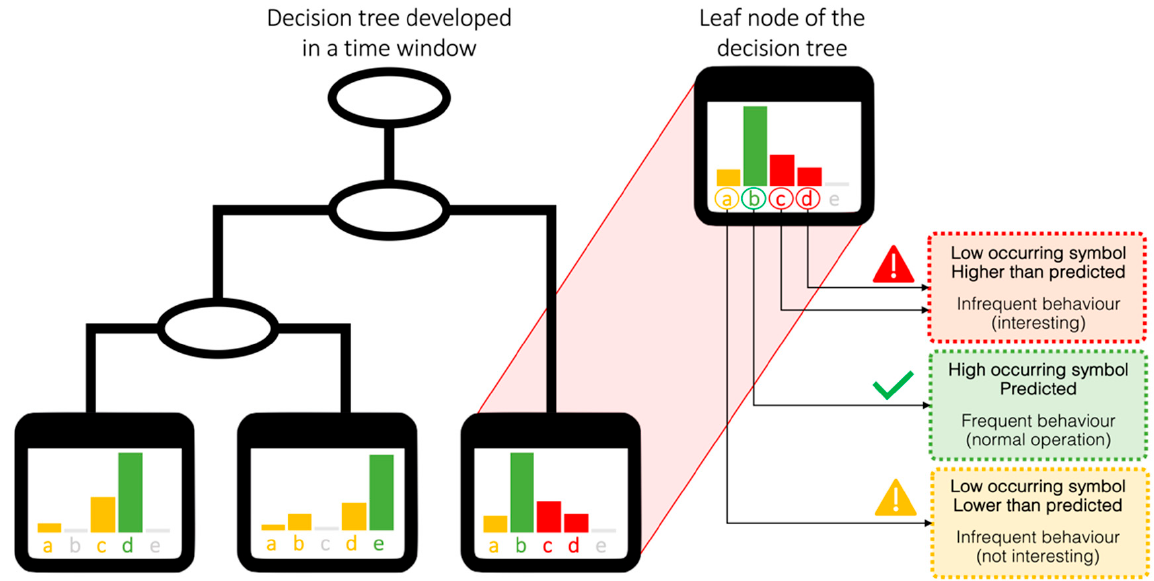
Figure 5. Interpretation of anomaly detection results.